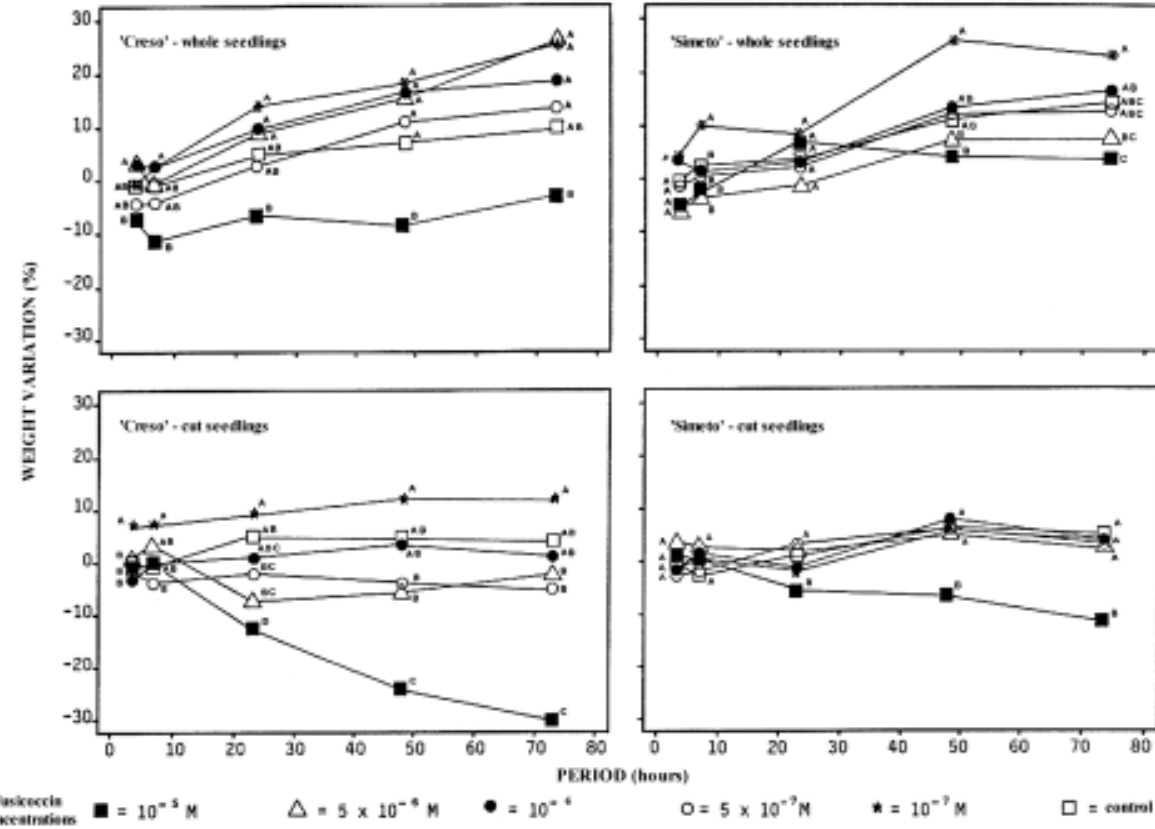
Fig. 1. Per cent variation in weight of whole or cut seedlings of two durum wheat cultivars during the absorption of FC solutions at various concentrations. Values are the means of 5 replications. For each treatment period, values without any common letter differ from each other at P =0.05 (Duncan’s